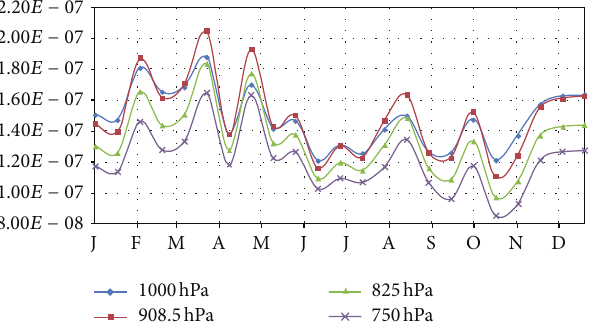
Figure 4: Time series for carbon monoxide measurements during 2007 concentrating on four pressure levels at 749 hPa, 825 hPa, 908 hPa, and